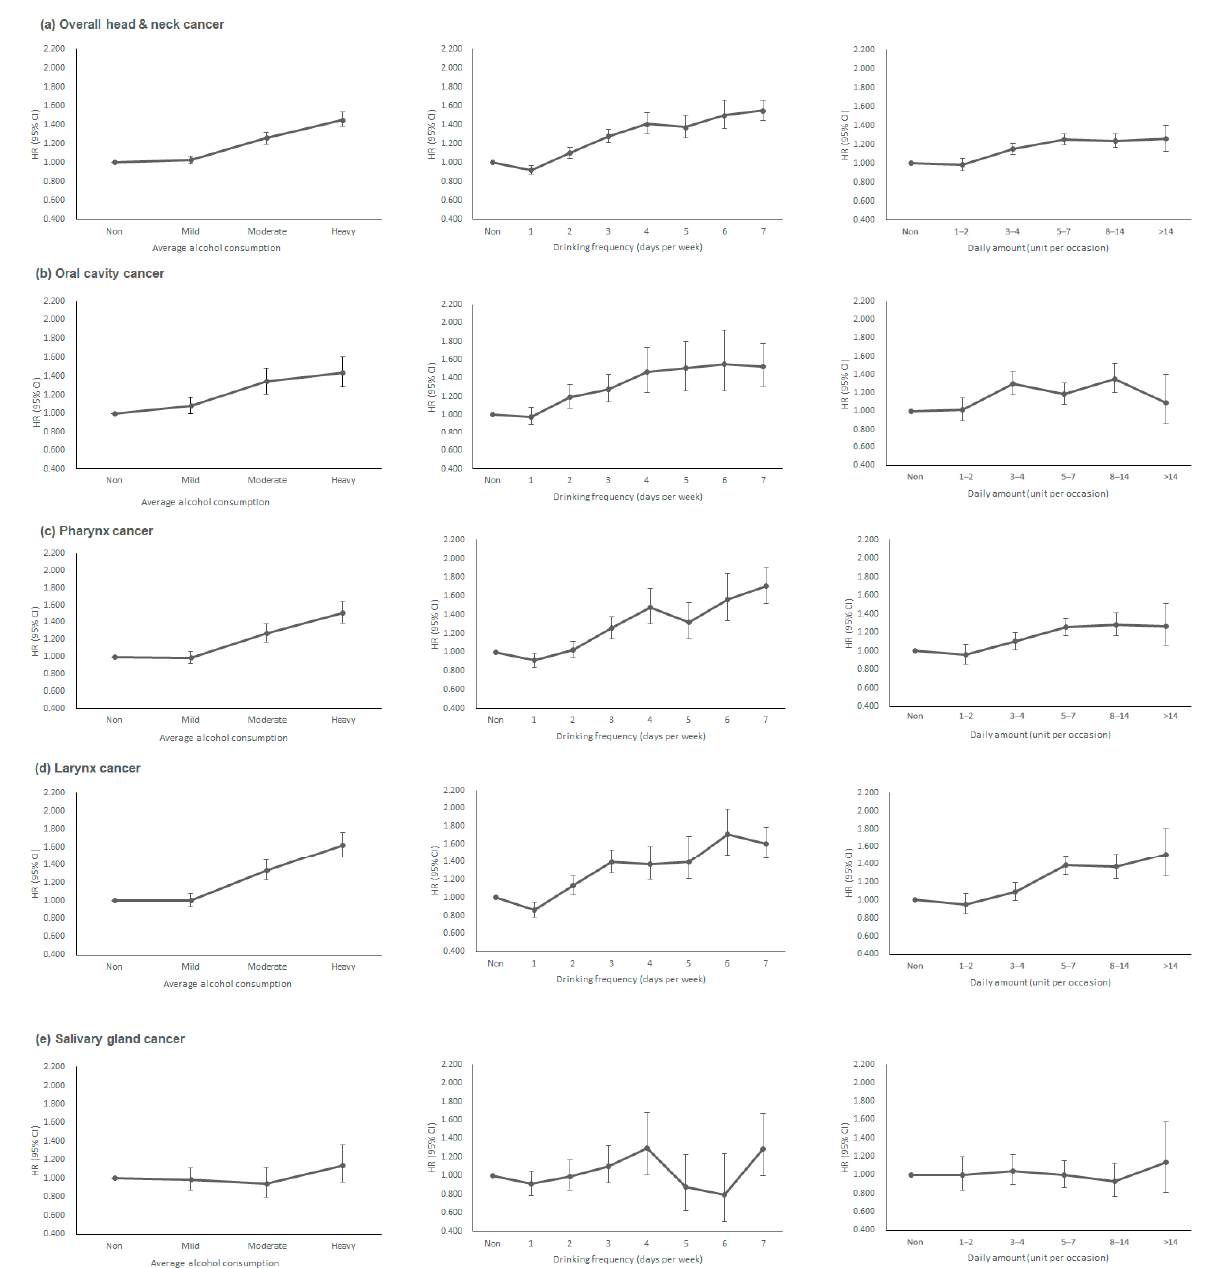
Figure 1. Risk of head & neck cancer according to alcohol drinking status. HR, hazard ratio; CI, confidence interval. HRs are adjusted for age, sex, income, smoking status, physical activity, body mass index, diabetes mellitus, hypertension and dyslipidemia. ( a ) overall head & neck cancer, ( b ) oral cavity cancer, ( c ) pharynx cancer, ( d ) larynx cancer, ( e ) salivary gland cancer.